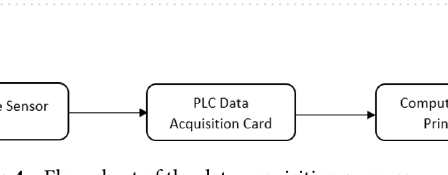
Figure 4. Flow chart of the data acquisition process.